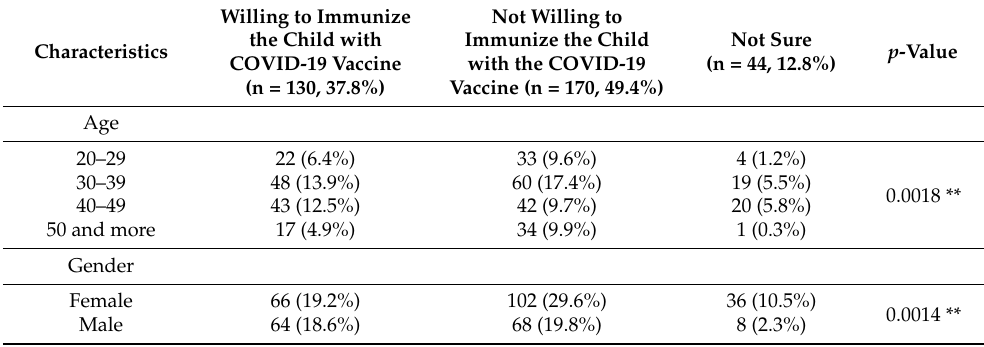
Table 3. Participants’ characteristics and their impact on participants’ willingness to vaccinate their